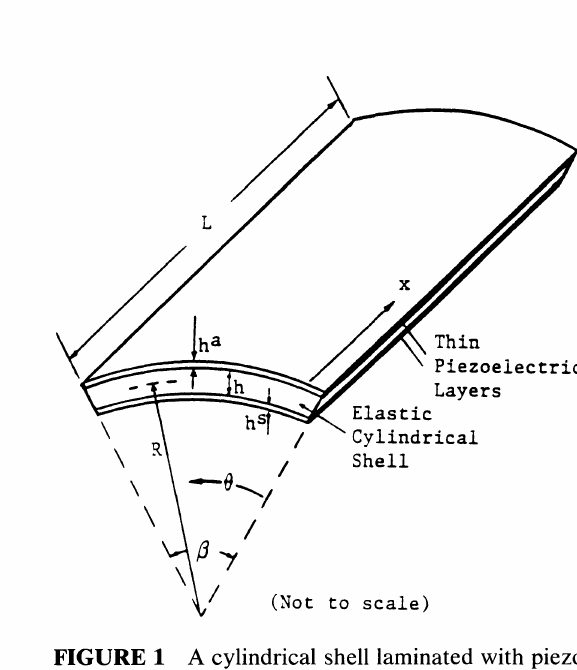
FIGURE 1 A cylindrical shelllarninated with piezo electric